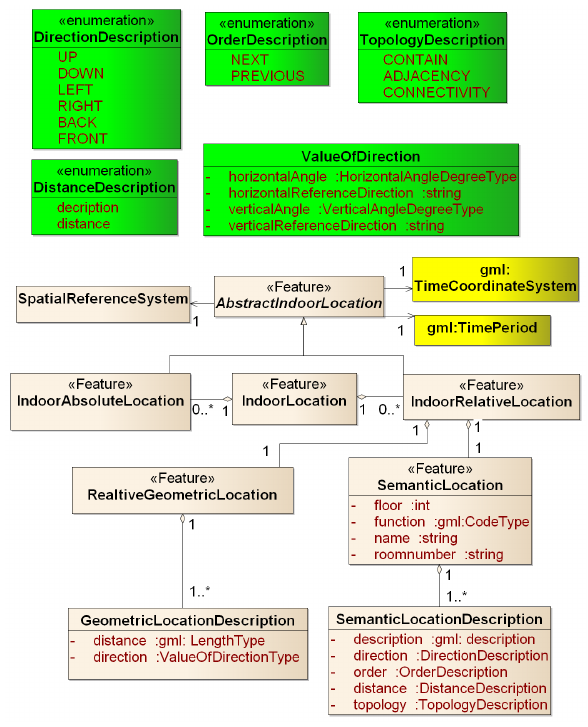
Figure 2. Main part of IndoorLocationGML (remade from Zhu et al.,